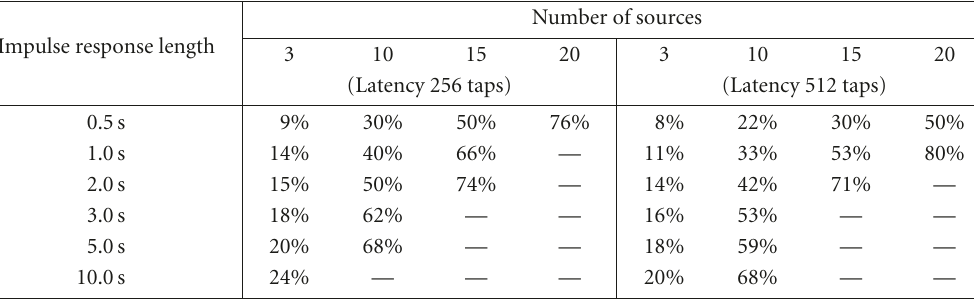
Table 1: CPU load of the low-latency convolution